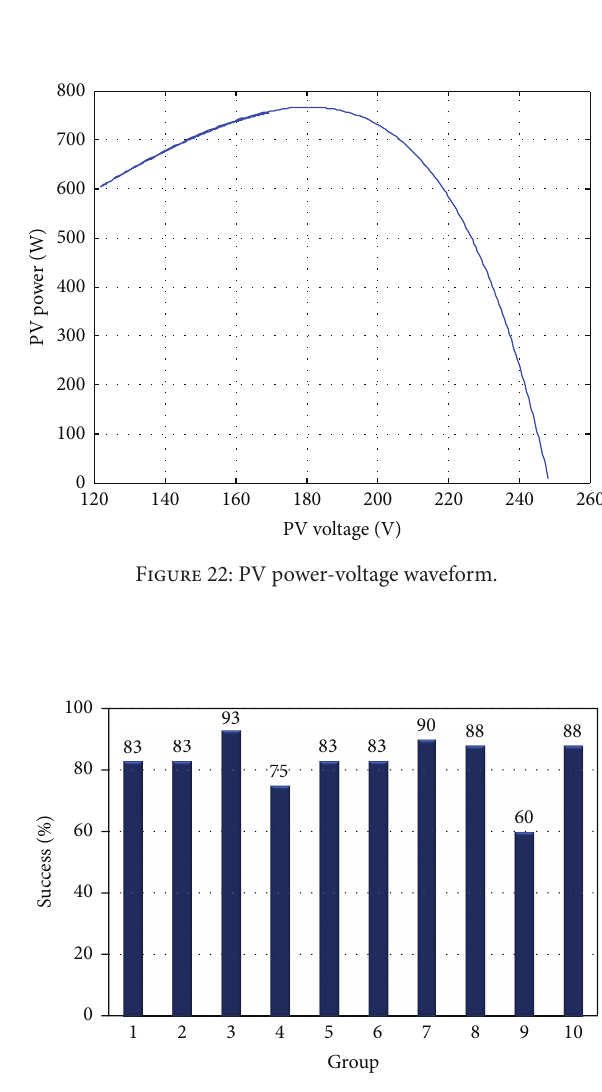
Figure 23: The group success in experiment in percentages.